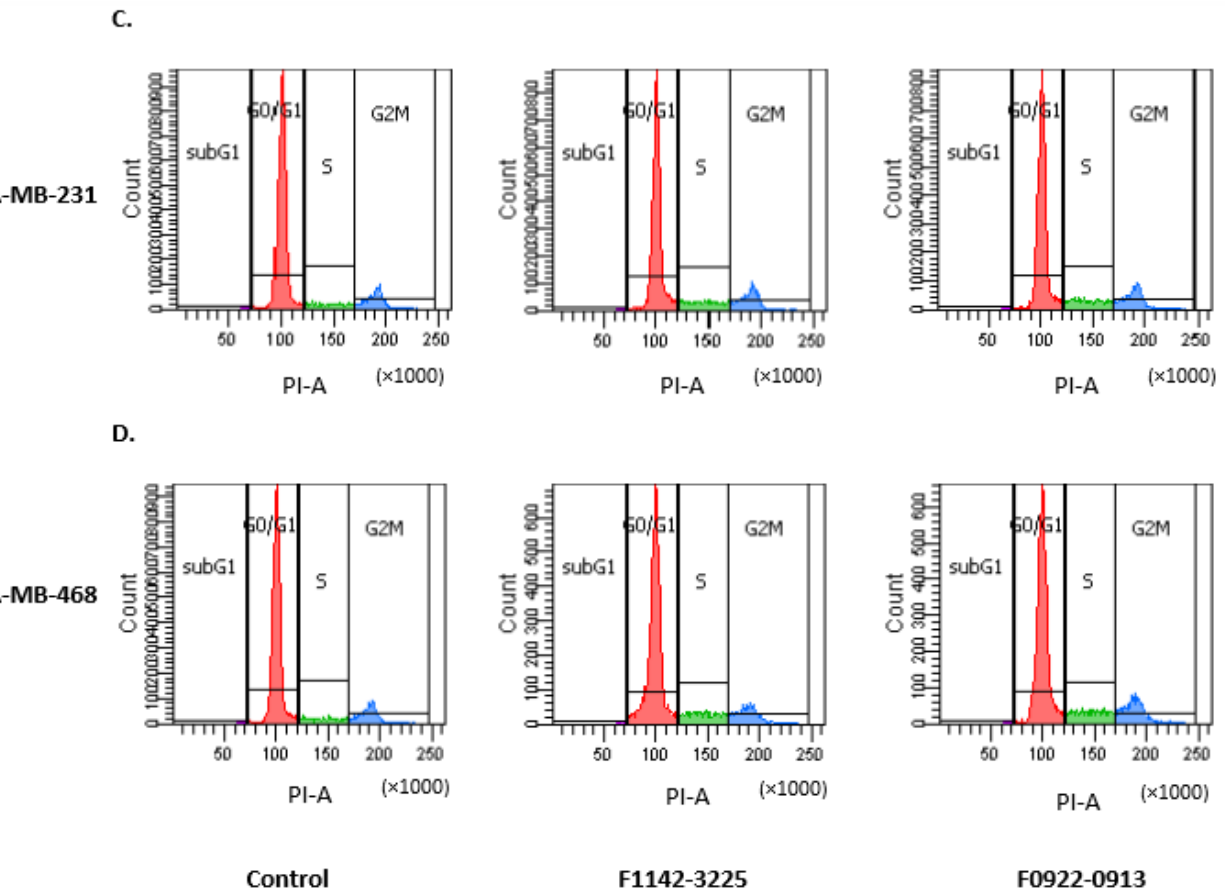
Figure 2. The cell cycle distribution of MDA-MB-231 and MDA-MB-468 cells in response to inhibitors. ( A , C ) Cell cycle distribution modification, induced by F1142-3225 or F0922-0913 in MDA-MB-231 cells; ( B , D ) cell cycle distribution, induced by F1142-3225 or F0922-0913 in MDA-MB-468 cells. Data are presented as % of living cells (G0/G1, S, and G2/M cells = 100%). Each value represents the mean of experiments carried out in triplicate (mean ± SD). Statistical significance by one-way ANOVA; * p ˂ 0.05 vs. control (ctrl). Flow cytometry figures depict the cellular distribution in each phase of the cell cycle after treatment.